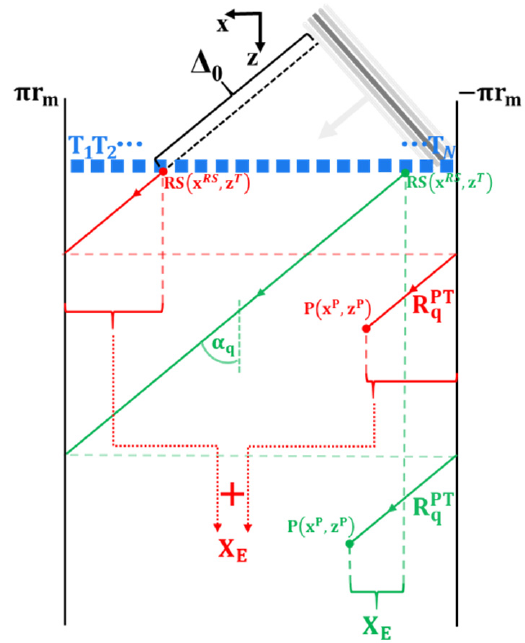
Figure 3. Outline of two cases of incident plane wave travel paths to focusing point P for a qth plane wave sent at an angle α q . R PT q is the incident wave travel path to P, RS is the start of this path at the array, array element T j is jth array element, r m is the mean radius of the pipe, X E is the length of the incident travel path projection in the circumferential direction minus the full pipe circumference repetitions accounting for the number of times the signal travelled around the pipe before reaching pixel P, and ∆ 0 is the correction factor offsetting the excitation to begin at t = 0. Unlike classic 2D PWI, where only a single direct ray path on reception from the focus point to the jth receiving element of the transducer array needs to be considered, here, in theory, there are infinite direct ray paths. All the backscattered signals from any point in the pipe will eventually reach the fully circumferential transducer array. This results in a virtually infinite aperture of the fully circumferential array. Additionally, each incident plane wave covers the entire interrogated area. This prevents the situation where the steering angle of a plane wave is out of range of the geometrical angles between the end array elements and an arbitrary reconstruction point which could lead to